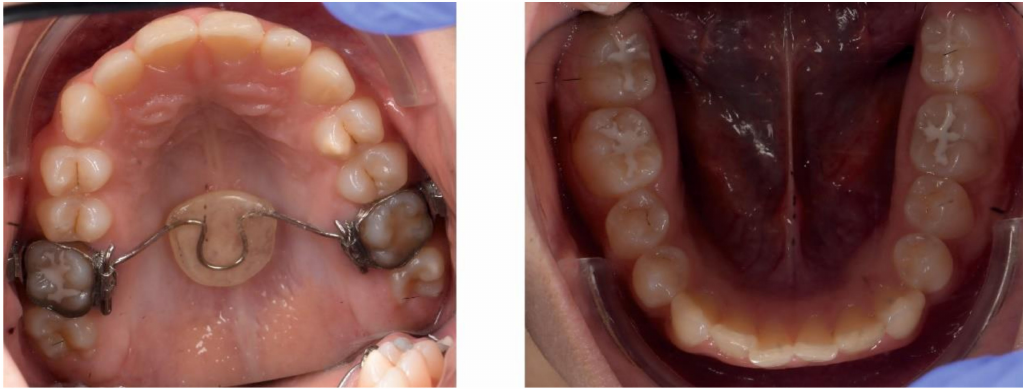
Figure 22. Intra-oral occlusal aspect at the end of treatment.